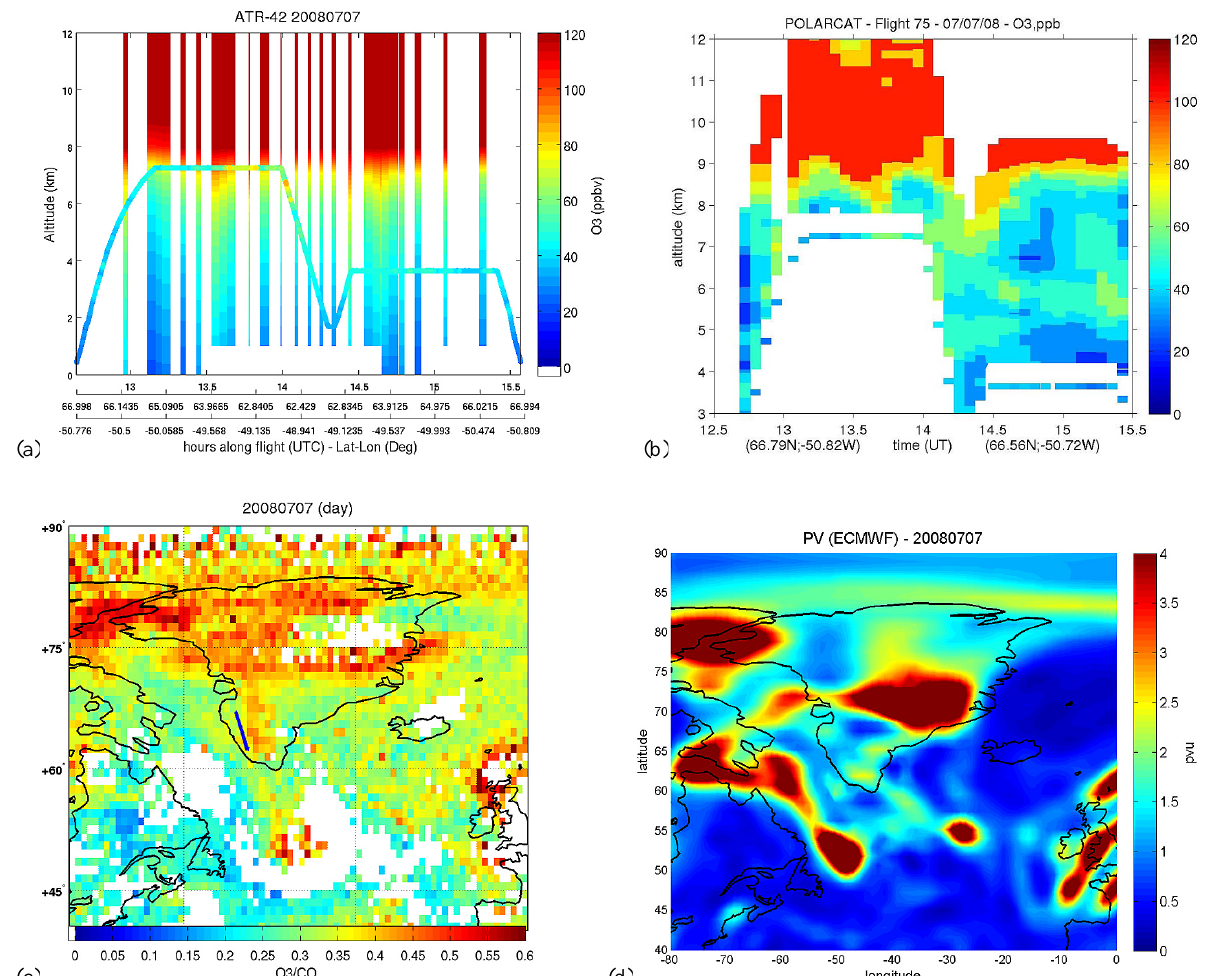
Fig. 12. In situ O 3 volume mixing ratios (ppbv) measured by the ATR-42 on 7 July 2008 compared to co-located IASI O 3 vertical distributions (using a criteria of [ ± 0.2 ◦ ; ± 1h]) along the flight (a) and O 3 lidar vertical measurements (b) . In situ (a) and lidar (b) data are plotted as a function of altitude versus time (UTC) along the flight track. The latitude and longitude on x-axis corresponds to the aircraft position (a) . Distribution of the ratio between daytime IASI O 3 [0–8km] partial columns and IASI CO total columns over Greenland on a 1 ◦ × 1 ◦ grid for 7 July 2008 with the ATR-42 flight track shown as a blue line (c) . White areas indicate no data. Potential vorticity (in PVU) at 8km over Greenland from ECMWF analysis data at 12:00UTC on 7 July 2008 (d)